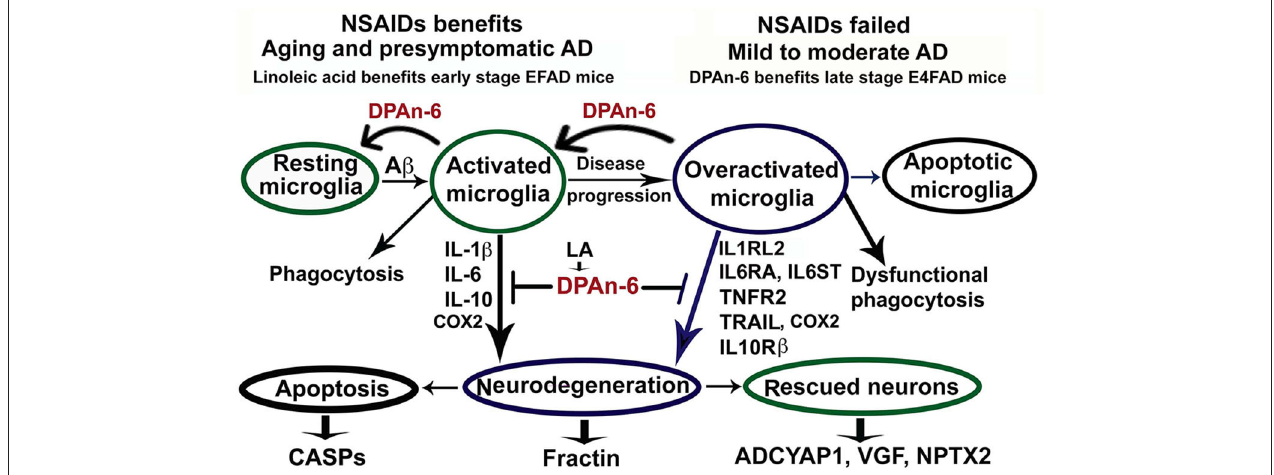
FIGURE 8 | Schematic representation of omega-6 fatty acid docosapentaenoic acid (DPAn-6) positively resolving neuroinflammation in early and late stages of Alzheimer’s disease (AD) models with the background of humanized APOE isoforms. In aging, MCI and early-stage AD, A β and other cellular debris can induce innate immune responses to activate microglia for phagocytosis ( 74). During this process, activated microglia release proinflammatory cytokines that can damage neurons if the response is not resolved adequately. Many studies have indicated that NSAIDs and other anti-inflammatory drugs, including COX2 inhibitors, can inhibit neuroinflammation in animal models (8, 9). However, clinical trials with these drugs have failed to date (12). Here we found that DPAn-6 resolved neuroinflammation in early-stage AD models, suggesting DPAn-6 may function similarly to NSAIDs. Further, with the progression of AD, sustainably activated microglia (overactivated microglia) may lose their phagocytotic function. These overactivated microglia may reduce expression of some known proinflammatory cytokines but sustain increases in cytokine receptors of IL1RL2, IL6RA, IL6ST, TNFR2, TRAIL, and IL10Rß ( 35–43), which may further damage neurons. Here we found that DPAn-6 suppressed the expression of these selected cytokines and cytokine receptors at late stages in the E4FAD model. It also improved toxicity evidenced by reductions of caspases and caspase-cleavage fragments. DPAn-6, which is normally produced in the liver and can be taken up by the brain in response to high n-6 diets, can resolve neuroinflammation at the late stage of AD models with advanced AD pathology in the background of APOE4 isoform, a strong genetic risk factor for